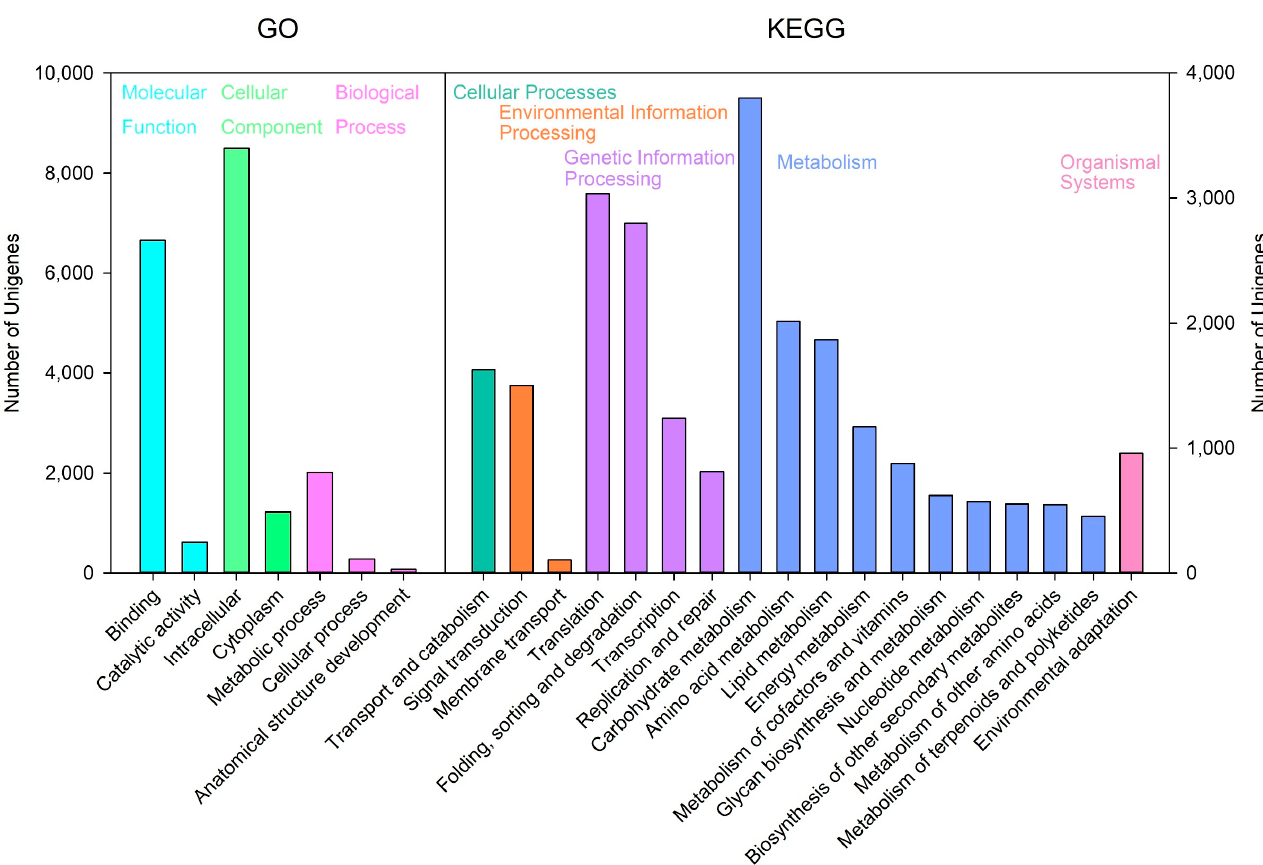
Figure 2. GO and KEGG classifications of the assembled unigenes in Agave angustifolia